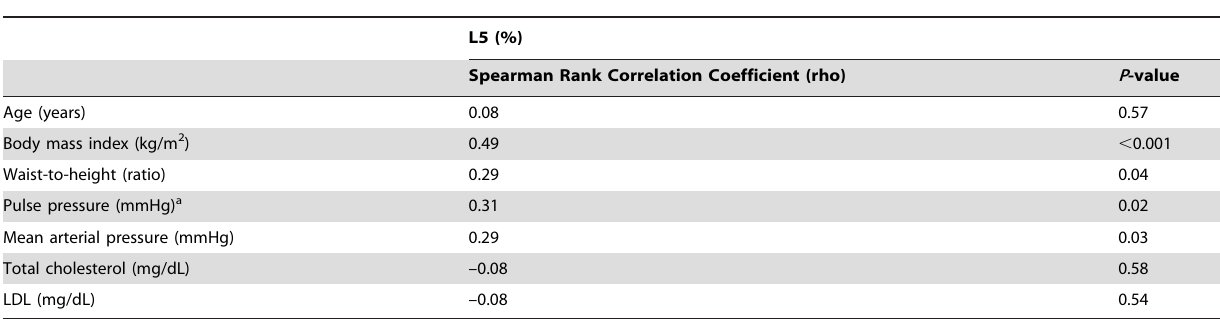
Table 2. Correlation of L5% and various CVD risk